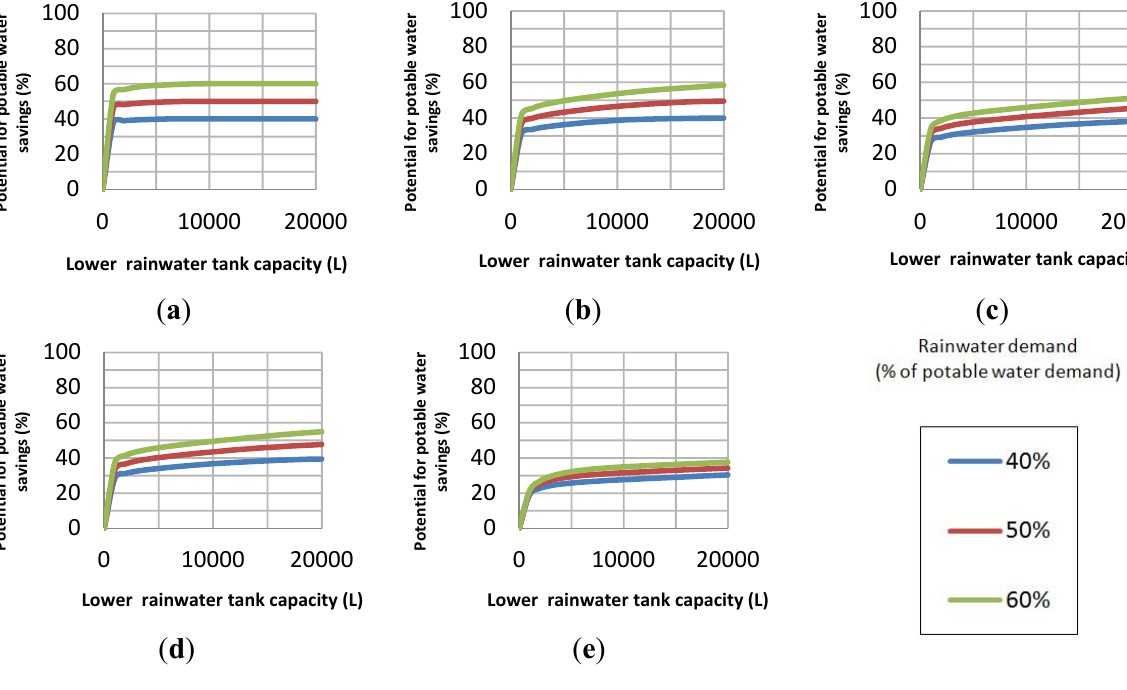
Figure 10. Potential for potable water savings as a function of lower rainwater tank capacity and potable water demand for Santarém, Brazil, for a catchment area of 100 m 2 and different potable water demands. ( a ) 100 L per house per day; ( b ) 300 L per house